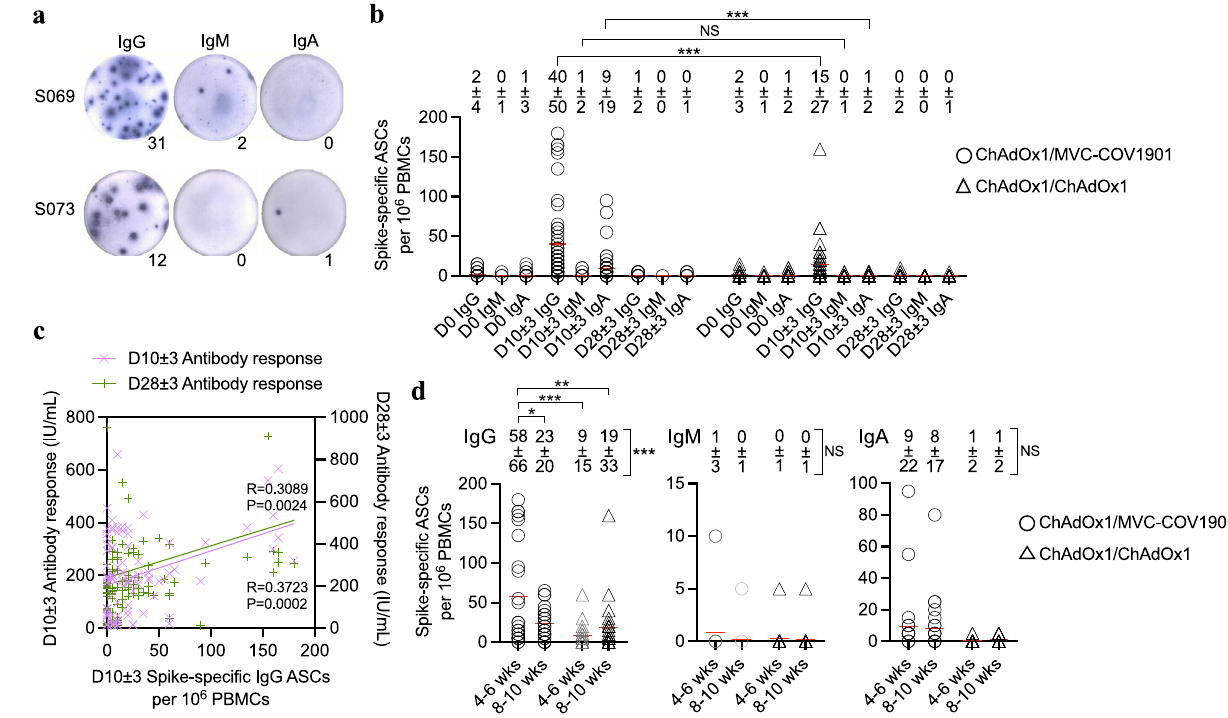
Fig. 5 | Antibody-secreting B cell response to SARS-CoV-2 spike is detected in recipients after the booster dose. a Representative ELISpot from one ChAdOx1/ MVC-COV1901 recipient (S069) and one ChAdOx1/ChAdOx1 recipient (S073). b IgG, IgM, IgA-secreting ASCs frequencies to spike prior to, at day 10±3, and day 28±3 after the booster dose in ChAdOx1/MVC-COV1901 ( n =49) and ChAdOx1/ ChAdOx1( n =45)groups.Themeanfrequencyofspike-speci fi cASCsresponseand its standard deviation at each time point is shown in the fi gure. Each point repre- sentsasingle recipientand red line representsthemean.The signi fi cancebetween twogroupswasdeterminedusingaMann – Whitneytest(two-tailed).Day10±3IgG, P =0.0007;Day10±3IgM, P =0.7674;Day10±3IgA, P =0.0010. c Therelationship betweenday10±3IgG-secretingASCsresponseandserologicalantibodyresponse at day 10±3 ( n =94) and day 28±3 ( n =94). Antibody titer was measured using a SARS-CoV-2 surrogate virus neutralization test and represented as international units (IU) per mL of serum. The correlation was determined using simple